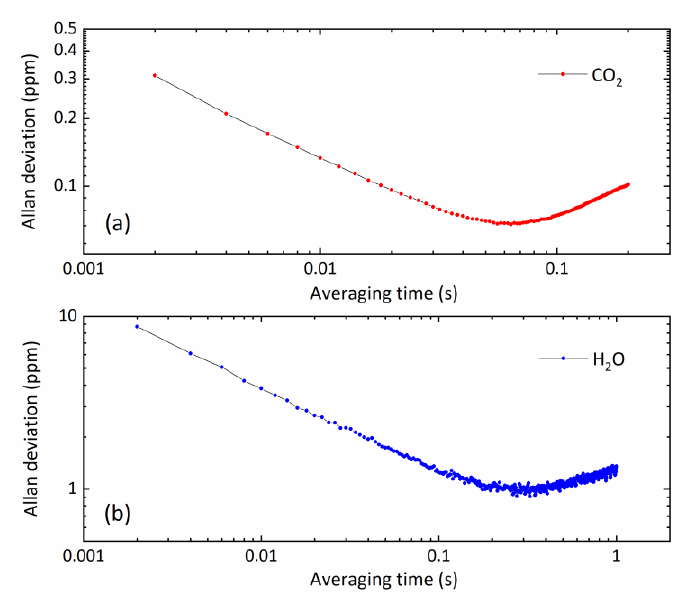
Figure 9. Allan deviation analysis of measurement stability of gas flow at a data rate of 500 Hz: ( a ) 42 ppm CO 2 and ( b ) 1200 ppm H 2 O.